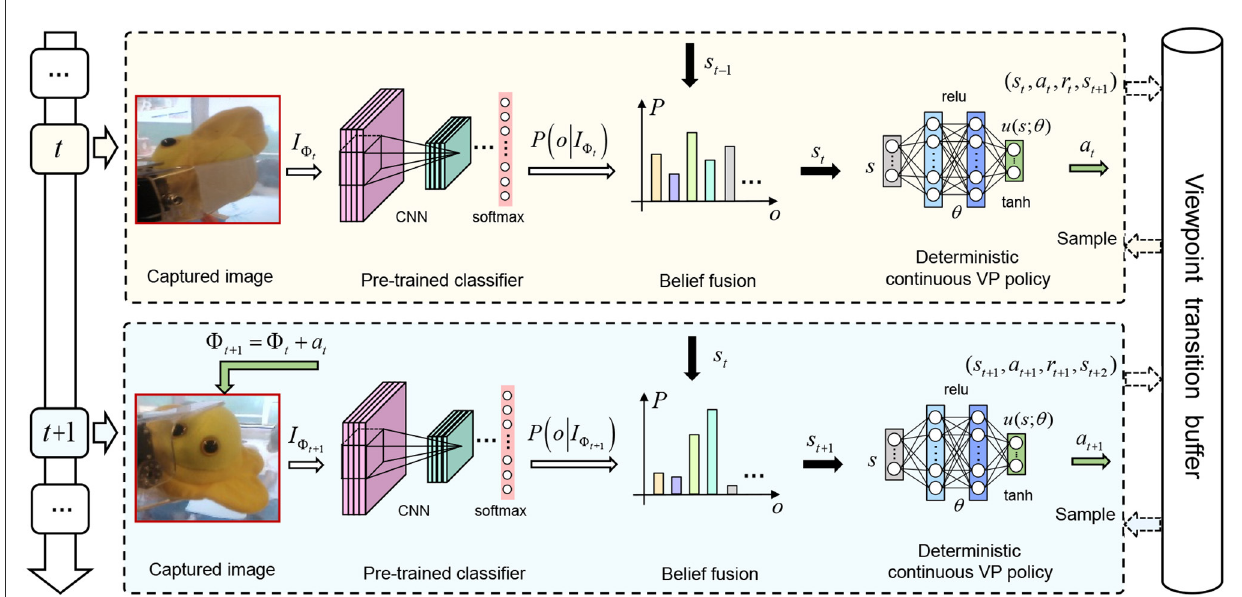
FIGURE2 The pipeline of active object recognition based on deterministic continuous viewpoint planning. The deterministic policy gradient theory (Silver et al., 2014) is introduced to build a framework of continuous viewpoint planning. We design a scheme of viewpoint transition management to store and replay the explored viewpoint transitions. Within the framework, we develop an algorithm based on TD3 (Fujimoto et al., 2018) and the scheme to train the VP policy network. During the training, the agent stores the explored viewpoint transition ( s t , a t , r t , s t + 1 ) in the viewpoint transition buffer and samples a mini-batch transitions from it to train the VP policy network at each time